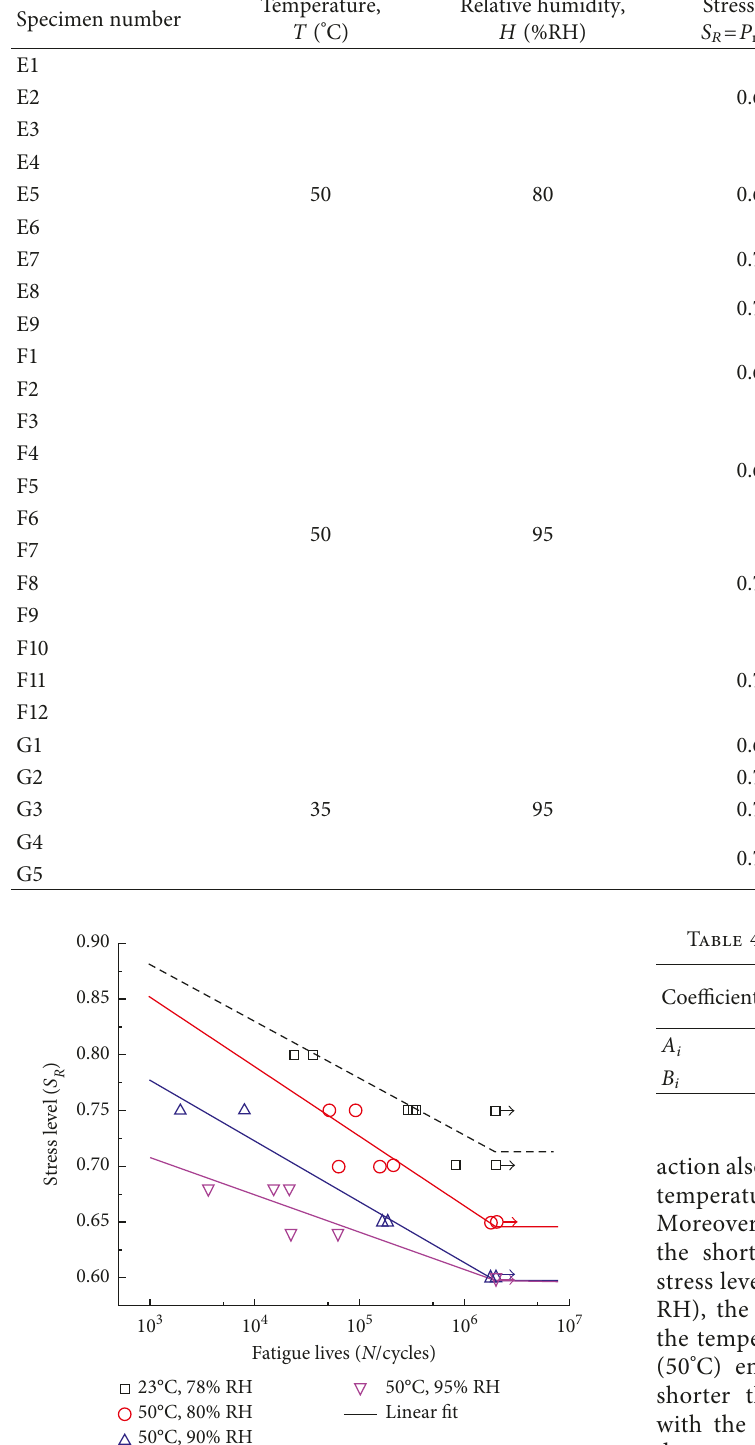
Table 3: Experimental conditions and results of group E ∼ G specimens.